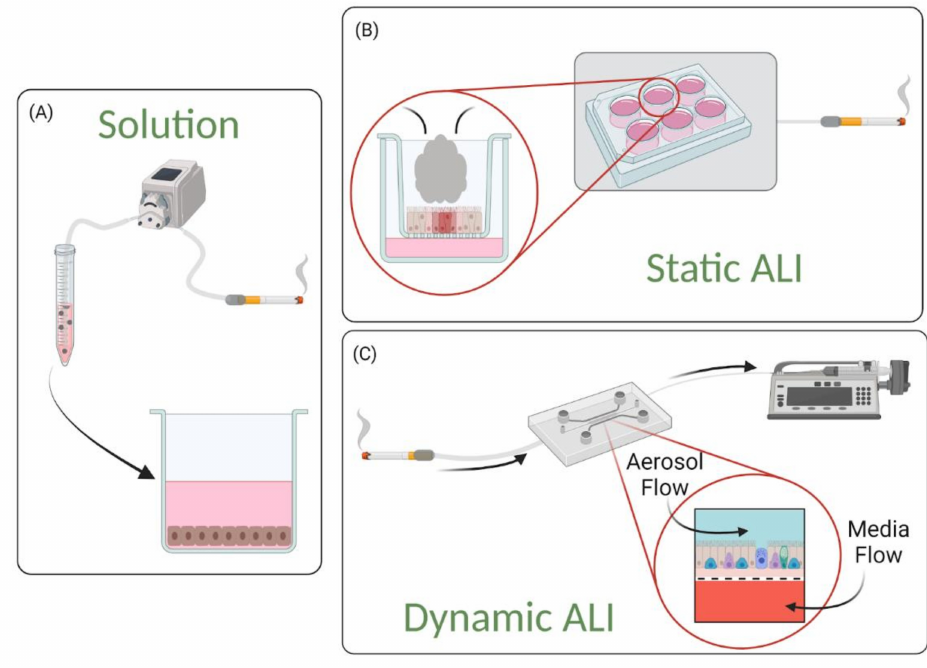
Figure 5. Schematic Description of Exposure Methods. ( A ) In solution-based exposures, a liquid extract is prepared by bubbling the gas through a buffer or cell culture medium. ( B ) In static ALI exposures, the smoke or aerosol is delivered in a single dose to cells cultured in a monolayer at the air–liquid interface (ALI). ( C ) In dynamic ALI exposures, the smoke or aerosol is delivered in a flow profile that mimics the inhalation